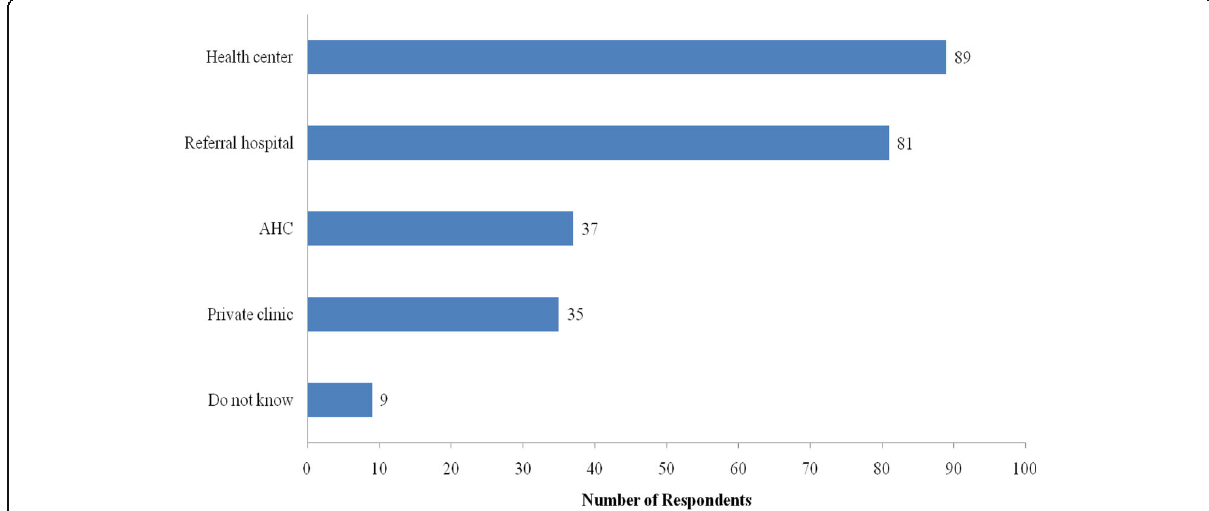
Fig. 2 Respondents ’ replies about where rabies vaccine is available ( n = 225). AHC Angkor Hospital for Children